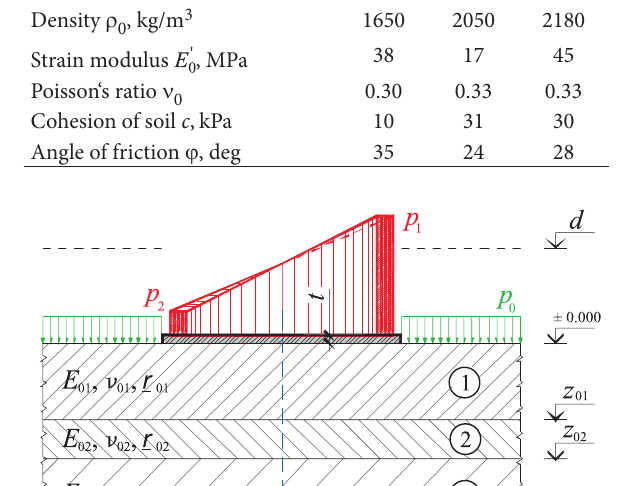
Table 1. The physical-mechanical properties of soil layers The property of soil layer